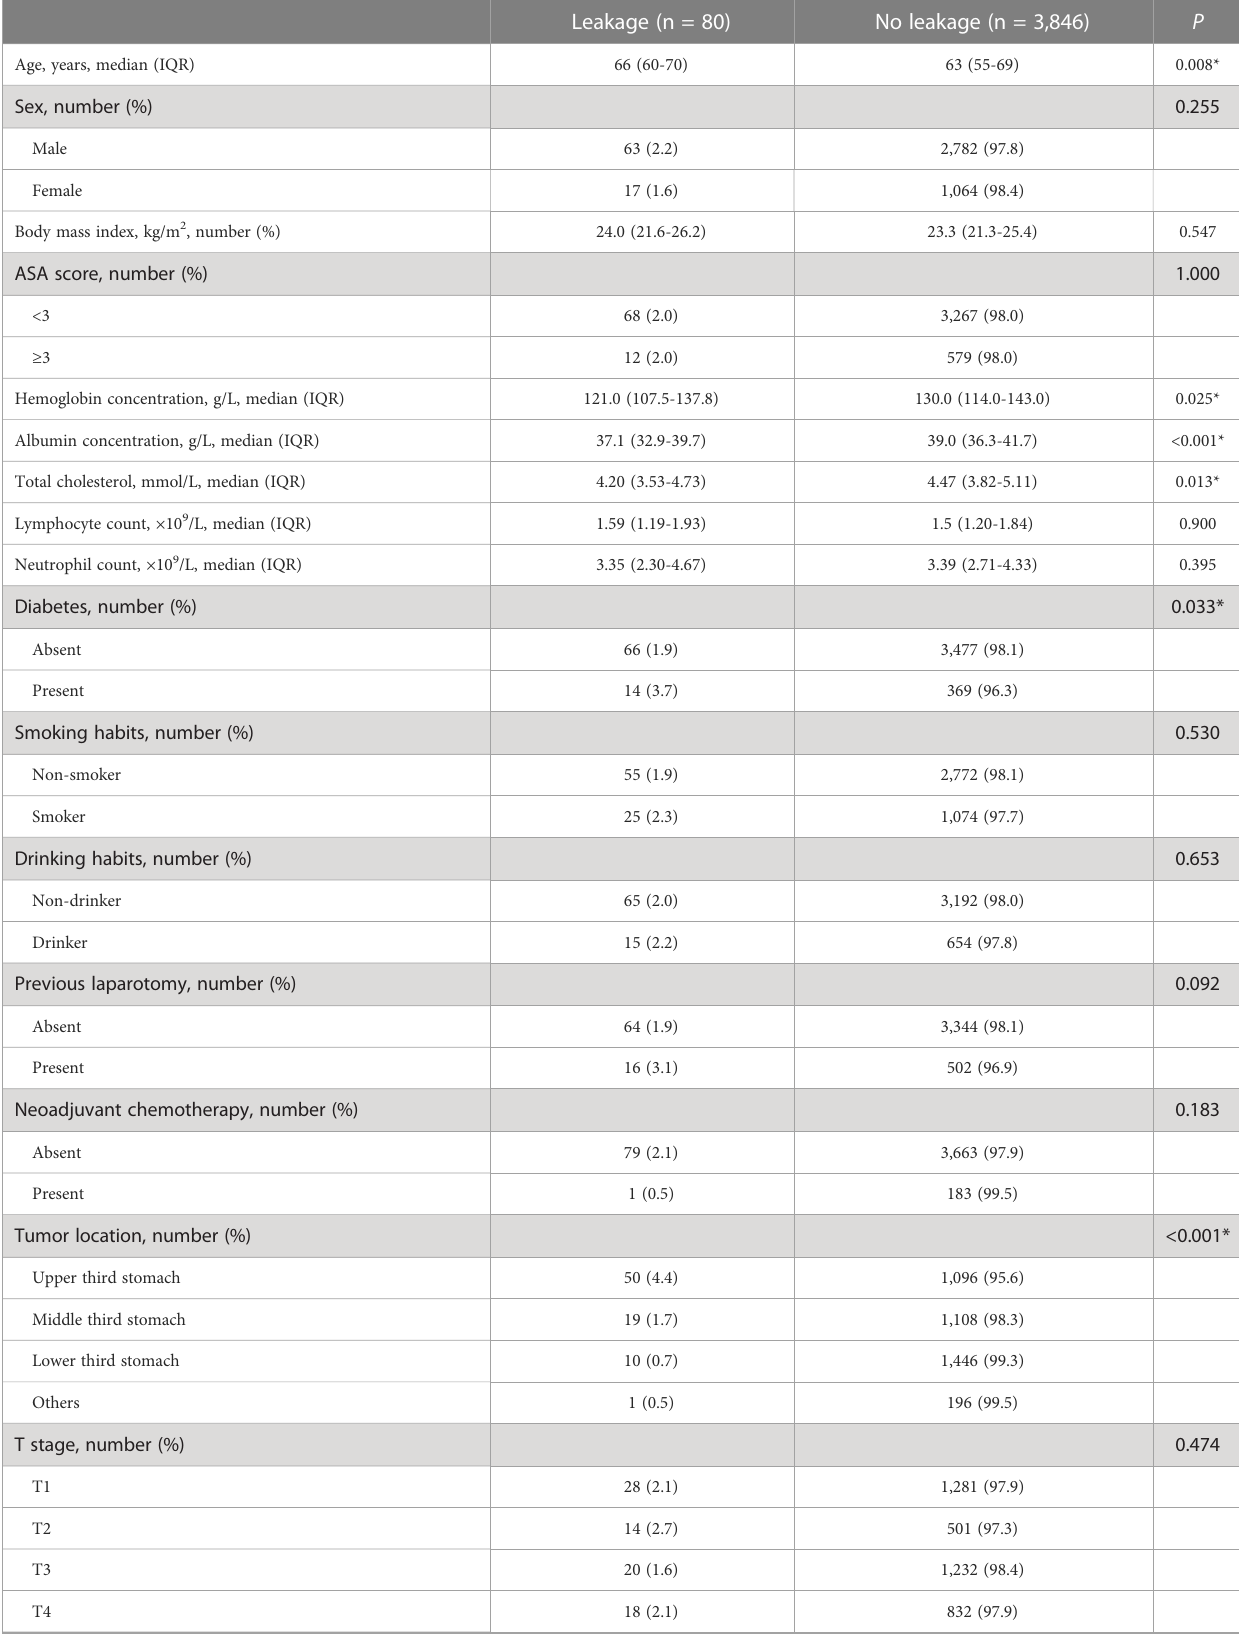
TABLE 4 Univariate analysis to identify clinicopathological and operative variables that are associated with anastomotic